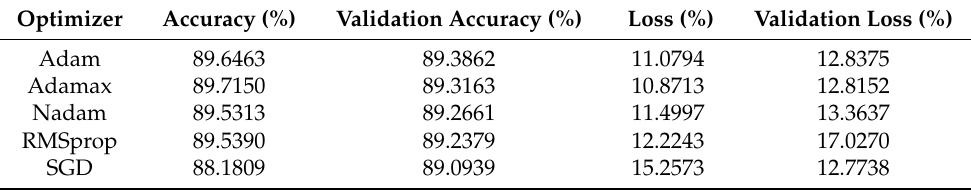
Table 1. Comparison with various optimizers.